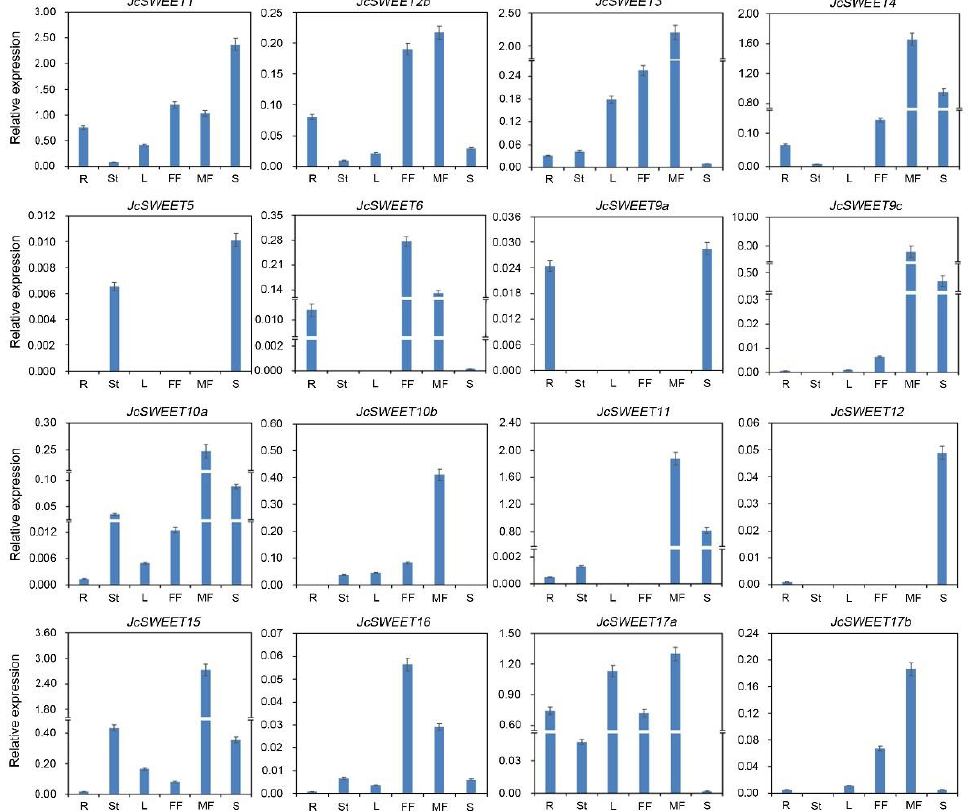
Figure 3. Expression analysis of JcSWEET genes in physic nut plants under normal conditions. R, root; St, stem cortex; L, leaf; FF, female flower; MF, male flower; S, seed. Relative expression was normalized to that of the reference gene JcActin (internal control).